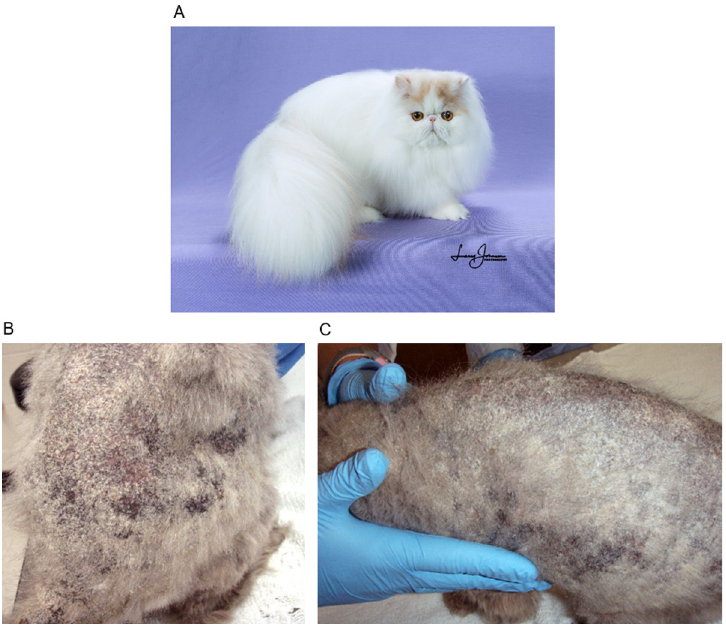
Fig 1. Macroscopic changes of a severe case of dermatophytosis in a Persian cat compared to a normal Persian cat. (A) A healthy, modern Persian cat with full hair coat. Photo courtesy of Larry Johnson. (B-C) Diffuse hair loss and scaling on the dorsum of a Persian cat with severe (chronic and extensive) dermatophytosis. This cat was not involved in the